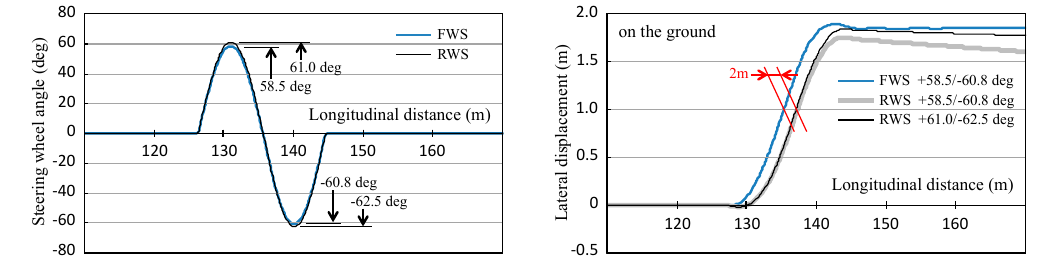
Figure 19. Steering wheel angle and lateral displacement on open loop simulation.